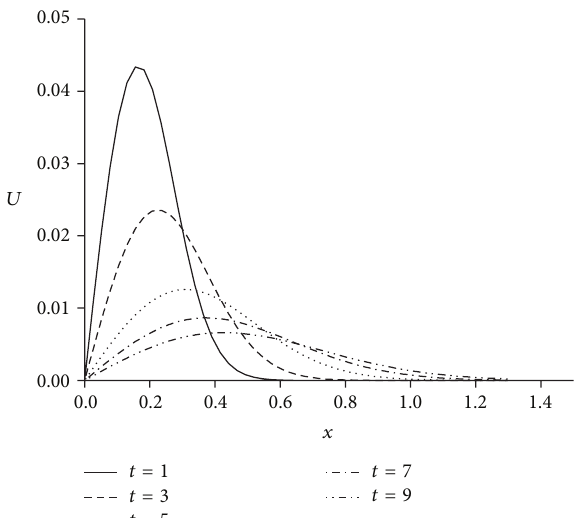
Figure 5: Solutions for V = 0.01 , ℎ = 0.02 , Δ𝑡 = 0.01 , and 0 ≤ 𝑥 ≤ 1.3 .